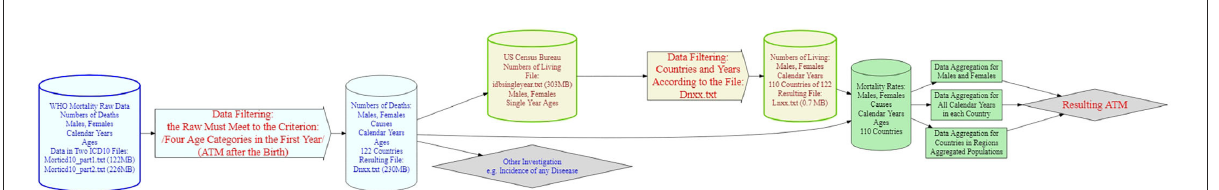
FIGURE1 Diagram of the process.